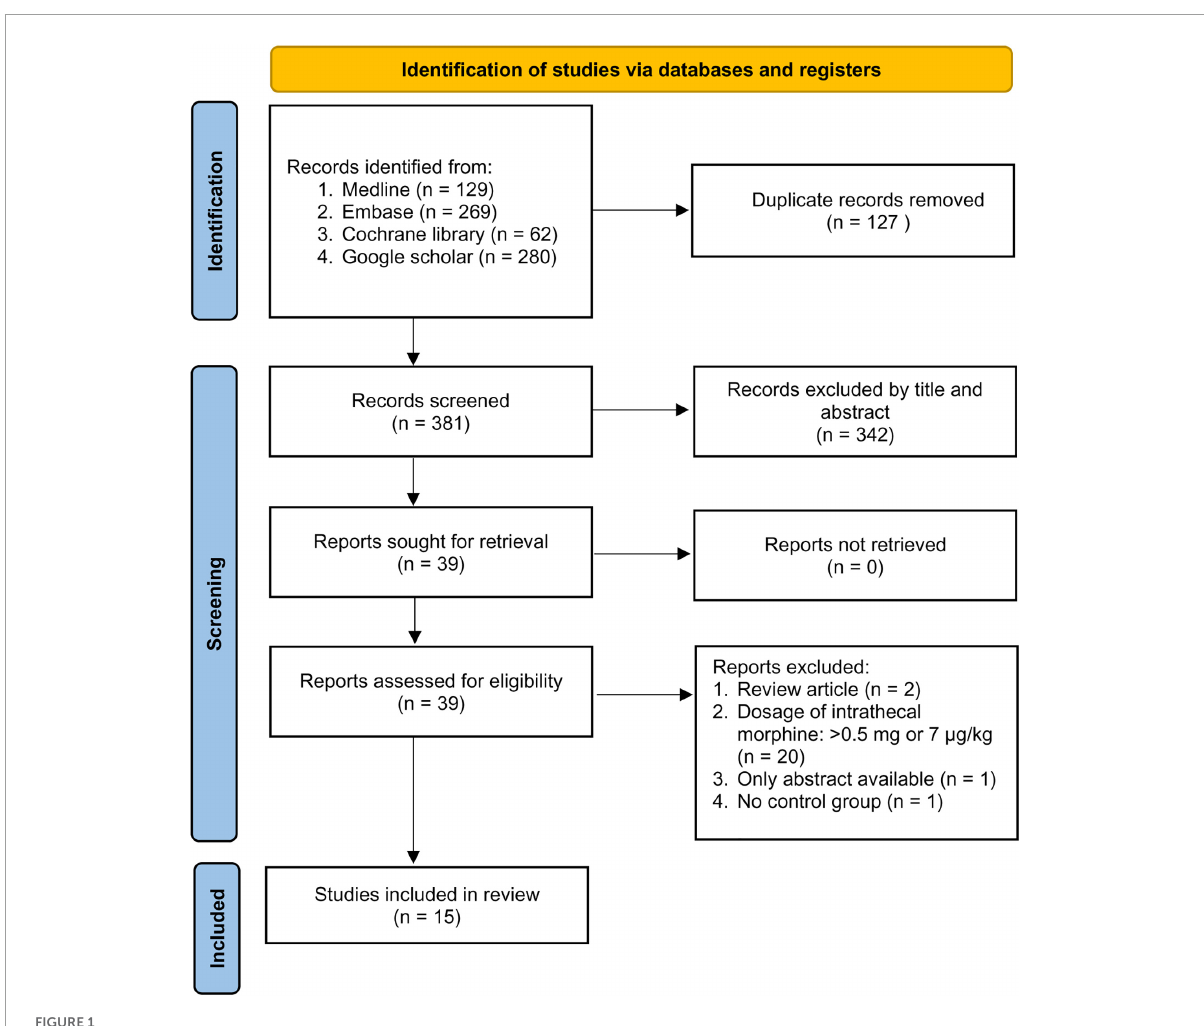
FIGURE1 PRISMA flow diagram of study selection for the current